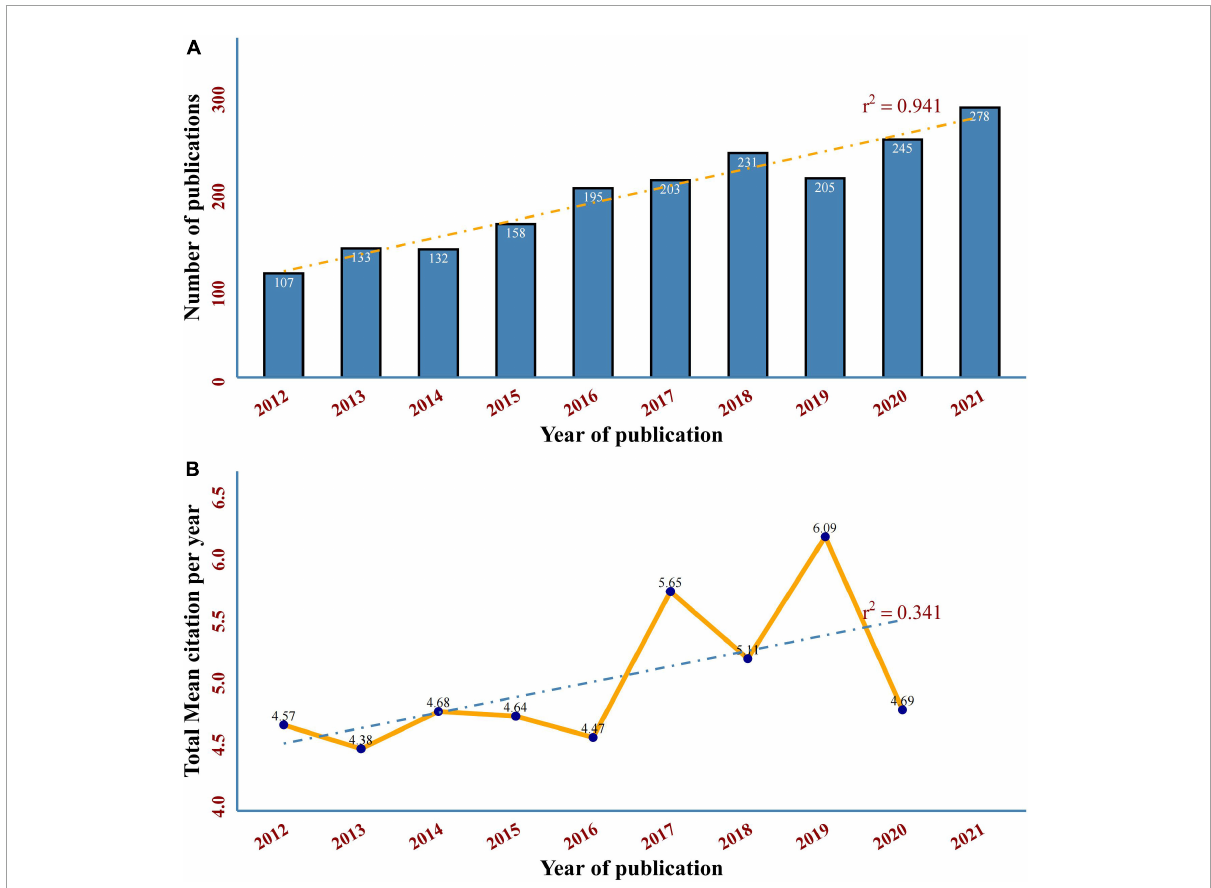
FIGURE2 (A) Annual trend chart of publications on DCM in 2012–2021. The dotted line represents linear growth with r 2 = 0.941. (B) Growth of the article cited per year in DCM. The dotted line represents linear growth with r 2 =